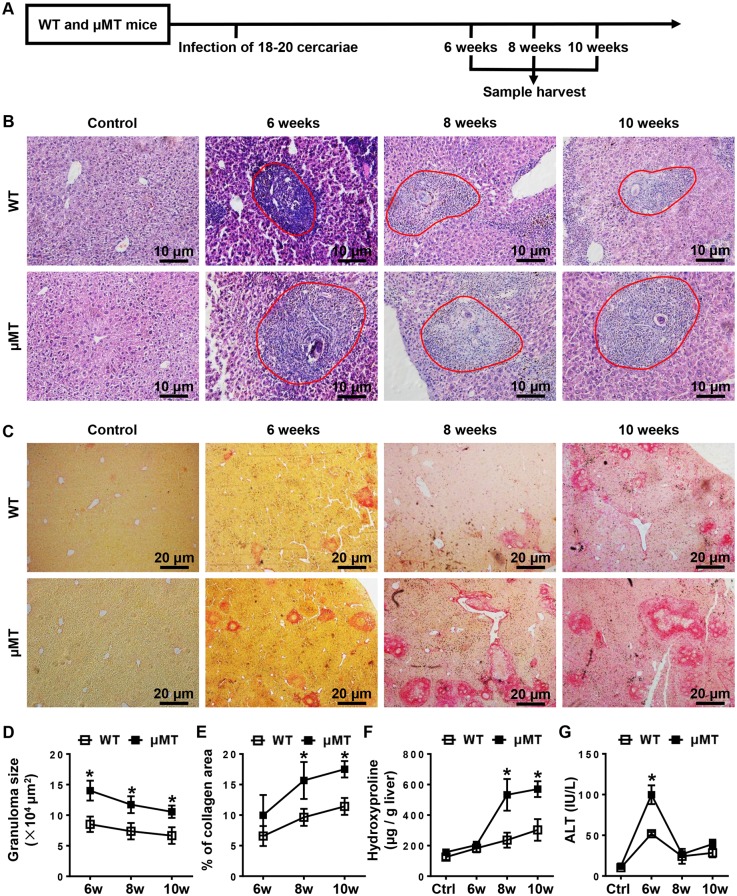
Mice lacking B cells exhibit more severe liver pathology than WT mice after S. japonicum infection.(A) Schematic representation of the model of S. japonicum infection. WT mice and μMT mice were infected with 18–20 cercariae of S. japonicum, and liver samples from these mice were harvested at the times indicated after infection. Comparisons were made with uninfected control mice. (B, C) Representative graphs of H&E staining (B) and picrosirius red staining (C) of liver specimens. (B) All images were taken at 200 × magnification. The red outlined areas indicate granulomas. (C) All images were taken at 40 × magnification. (D-G) Statistical analysis of granuloma sizes (D), proportion of collagen areas (E), amount of hepatic hydroxyproline (F), and levels of serum ALT (G). Data represent mean ± SD; n = 8–10 per time point from two independent experiments. *p < 0.05, versus WT mice.